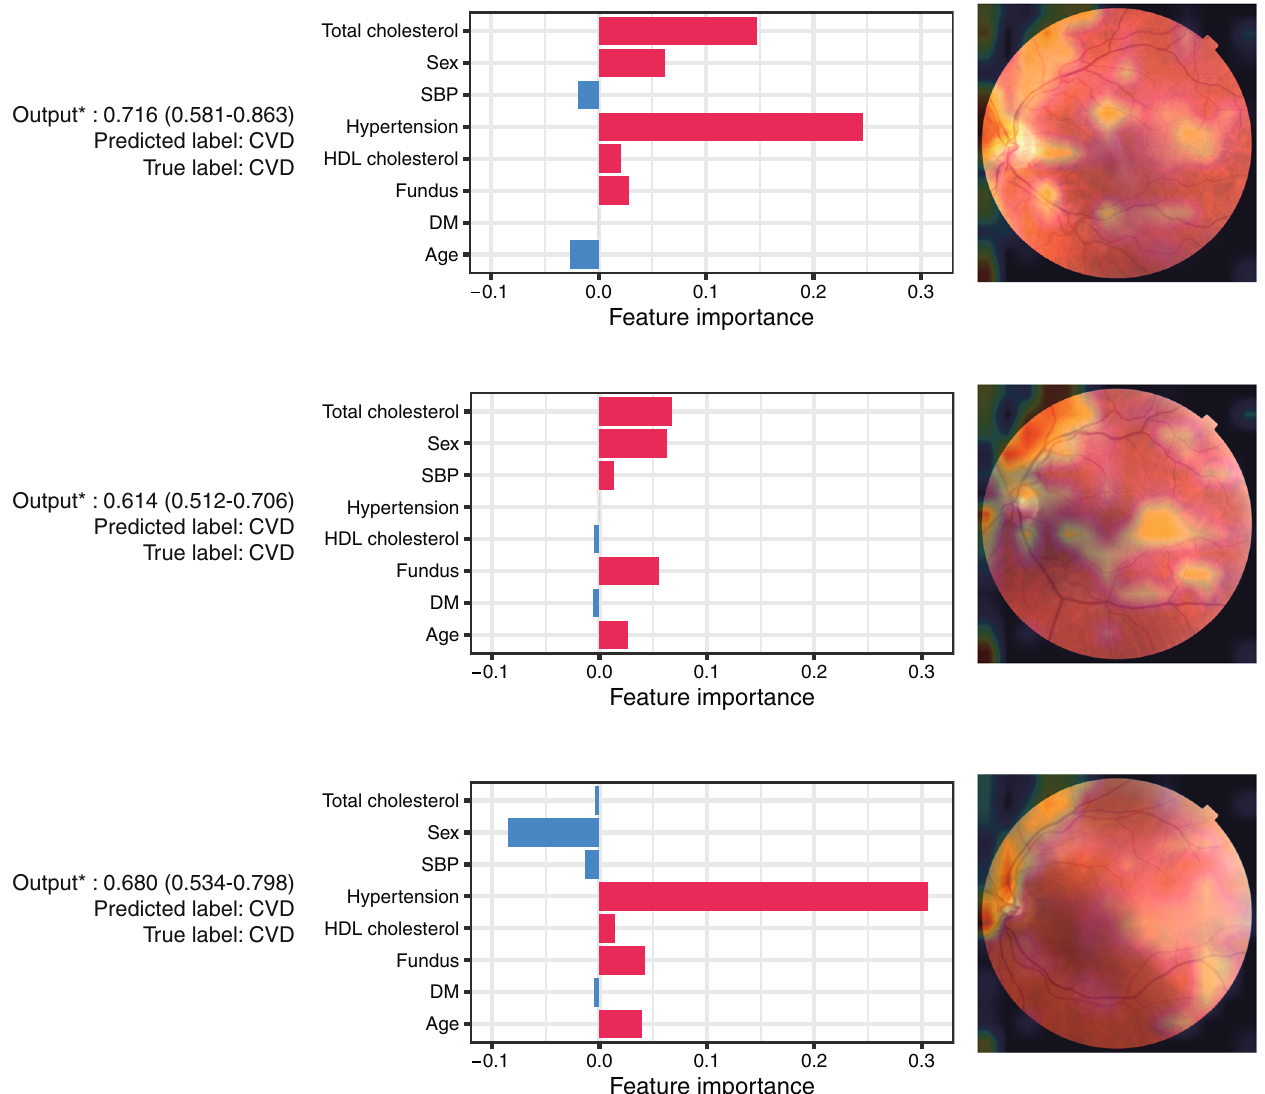
Fig. 6 Examples of true positives in the external validation for interpretation. The predicted scores (output) are described with the probability of the sample and 95% uncertainty interval (left). The SHAP values for contributions of variables are depicted in the middle. Positive feature importance (red) indicates that the variable may be a risk factor for predicting CVD, whereas a negative (blue) variable indicates a protective feature. Heatmap generation with fundus photographs using Grad-CAM (right). CVD cardiovascular disease, Grad-CAM gradient-weighted class activation mapping, SHAP Shapley additive